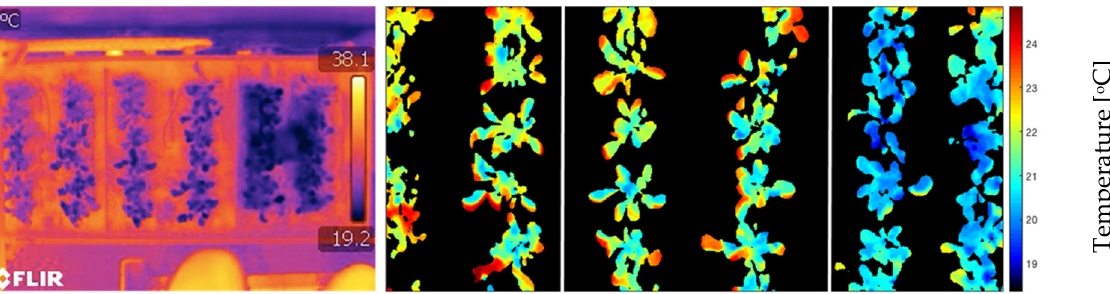
Figure 8. Generated thermal image, at 25DAP (Day After Planting), by the ( left ) original and ( right ) resized IR camera, with the overlay of the processed image for segmentation of the plants.